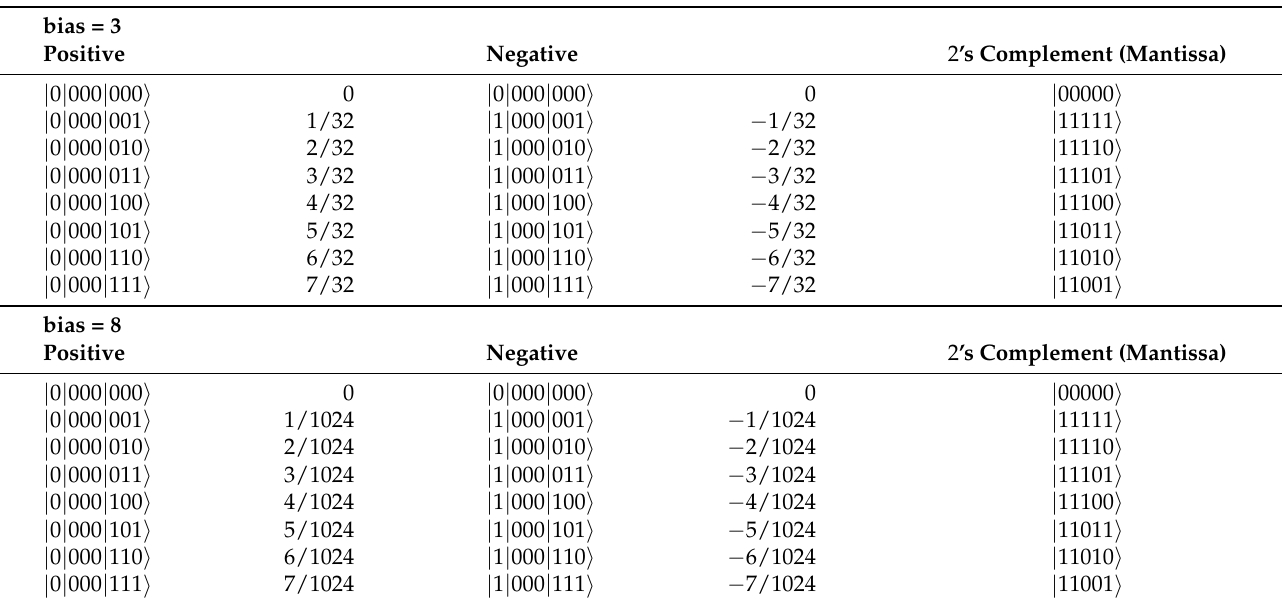
Table A1. Sub-normal floating-point numbers with four mantissa and three exponent qubits. The sign is defined by the leading qubit.